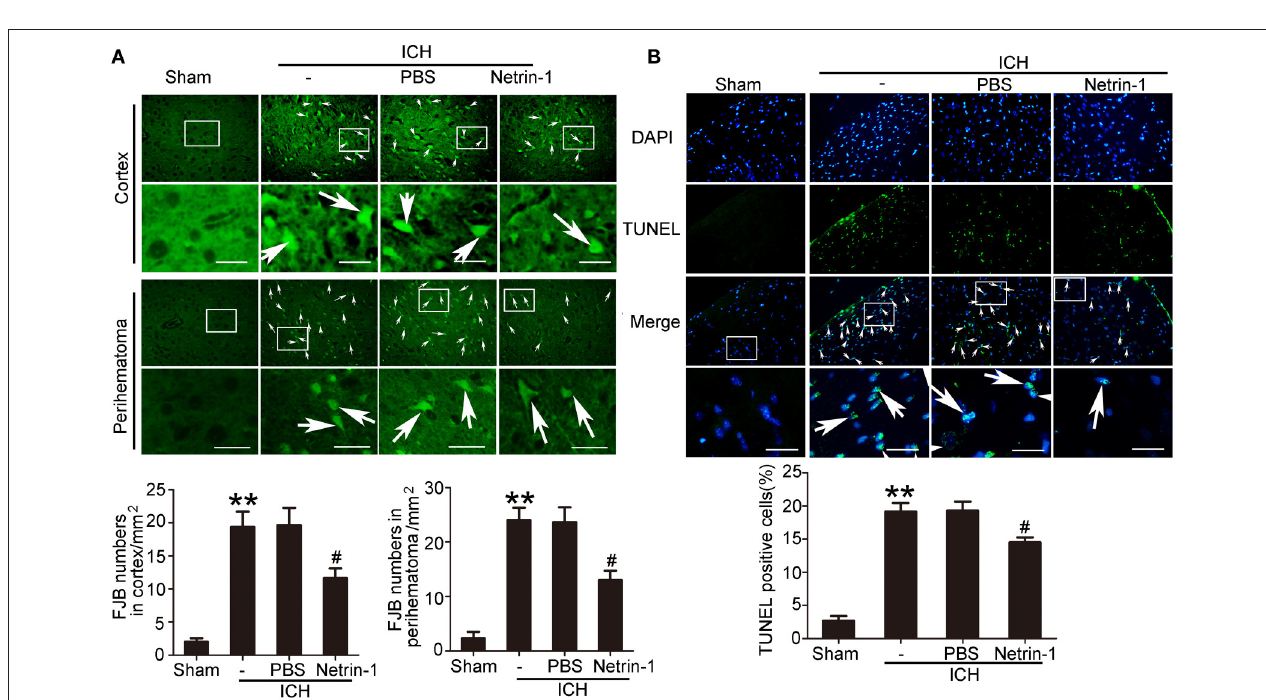
FIGURE 7 | Effects of exogenous recombinant netrin-1 on ICH-induced SBI. (A) FJB staining (green) shows neuronal degradation in the cerebral cortex and peri-hematoma region. Scale bar = 32 µ m. Arrows indicate FJB-positive cells, and number of FJB-positive cells/mm 2 was determined. All values are expressed as mean ± SEM. ** p < 0.01 vs. the sham group. # p < 0.05 vs. the ICH + PBS group, n = 6. (B) TUNEL (green) with DAPI (blue) staining in the peri-hematoma cortex and determination of the percentage of TUNEL-positive cells. Arrows indicate apoptotic cells. Scale bar = 32 µ m. All values are expressed as mean ± SEM. ** p < 0.01 vs. the sham group. # p < 0.05 vs. the ICH + PBS group, n = 6.